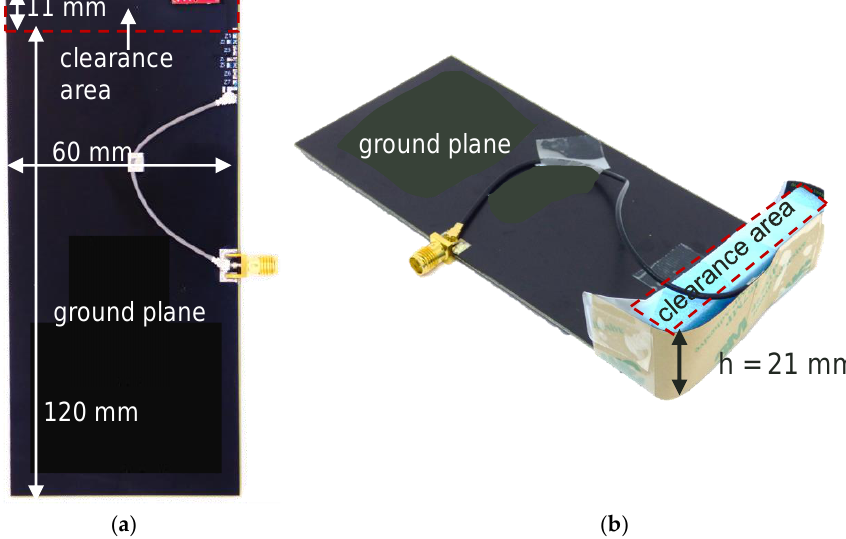
Figure 6. ( a ): 12 mm × 3 mm × 2.4 mm antenna booster on a 131 mm × 60 mm PCB, including a matching network with SMD components. ( b ): the 96 mm × 21 mm FPC antenna. Table 3. Measured total efficiency for the FPC and booster